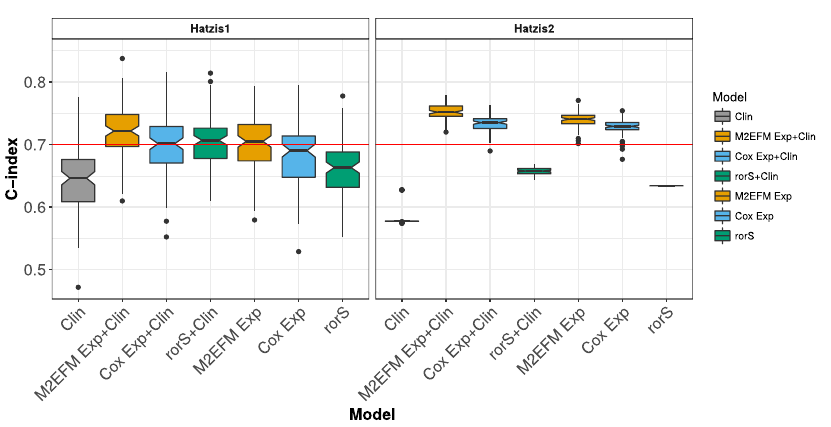
Figure 4. C-index for expression-only DRFS models across 100 random splits of Hatzis1 data into training and testing data for the various approaches, which were then validated on Hatzis2. The M2EFM models were the best performing on both testing and external validation